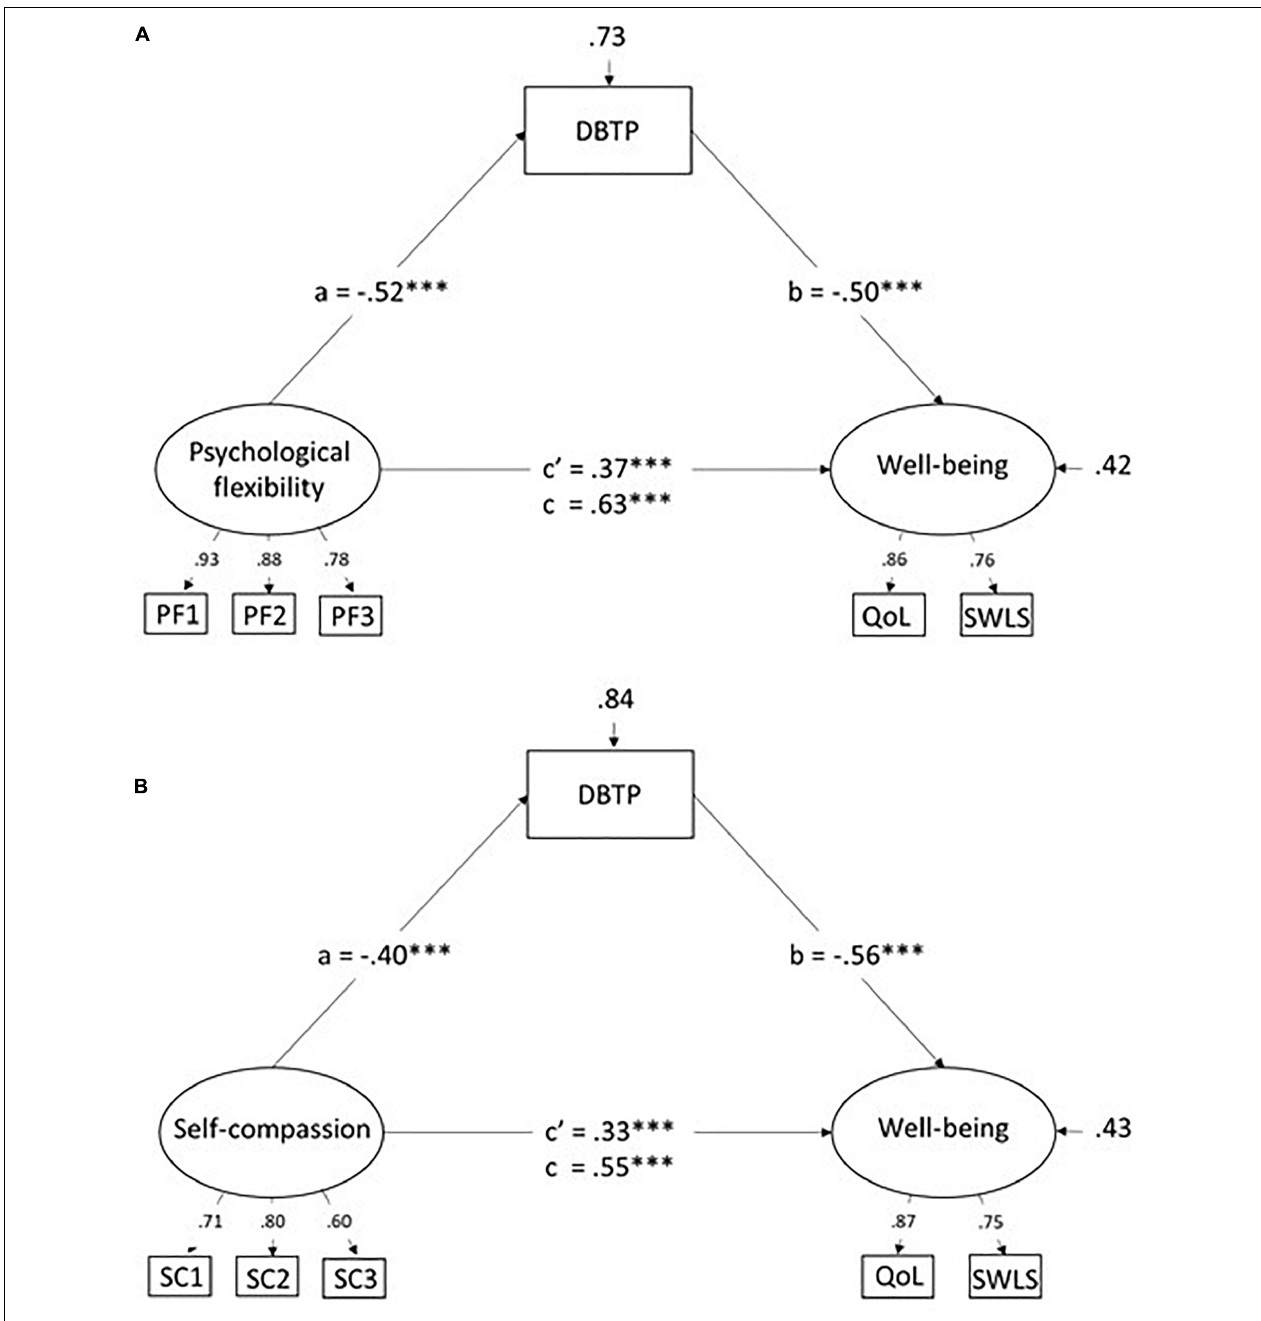
FIGURE 1 | (A,B) Models involving deviations from a balanced time perspective (DBTP) as a mediator of the relationship between psychological flexibility and well-being (A) or between self-compassion and well-being (B) . Values are standardized coefficents. c’ = direct effect, c = total effect.